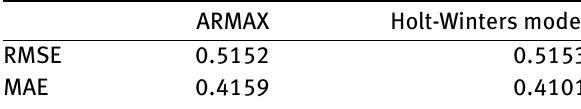
Table 2: Goodness of fit of ARMAX and H-W